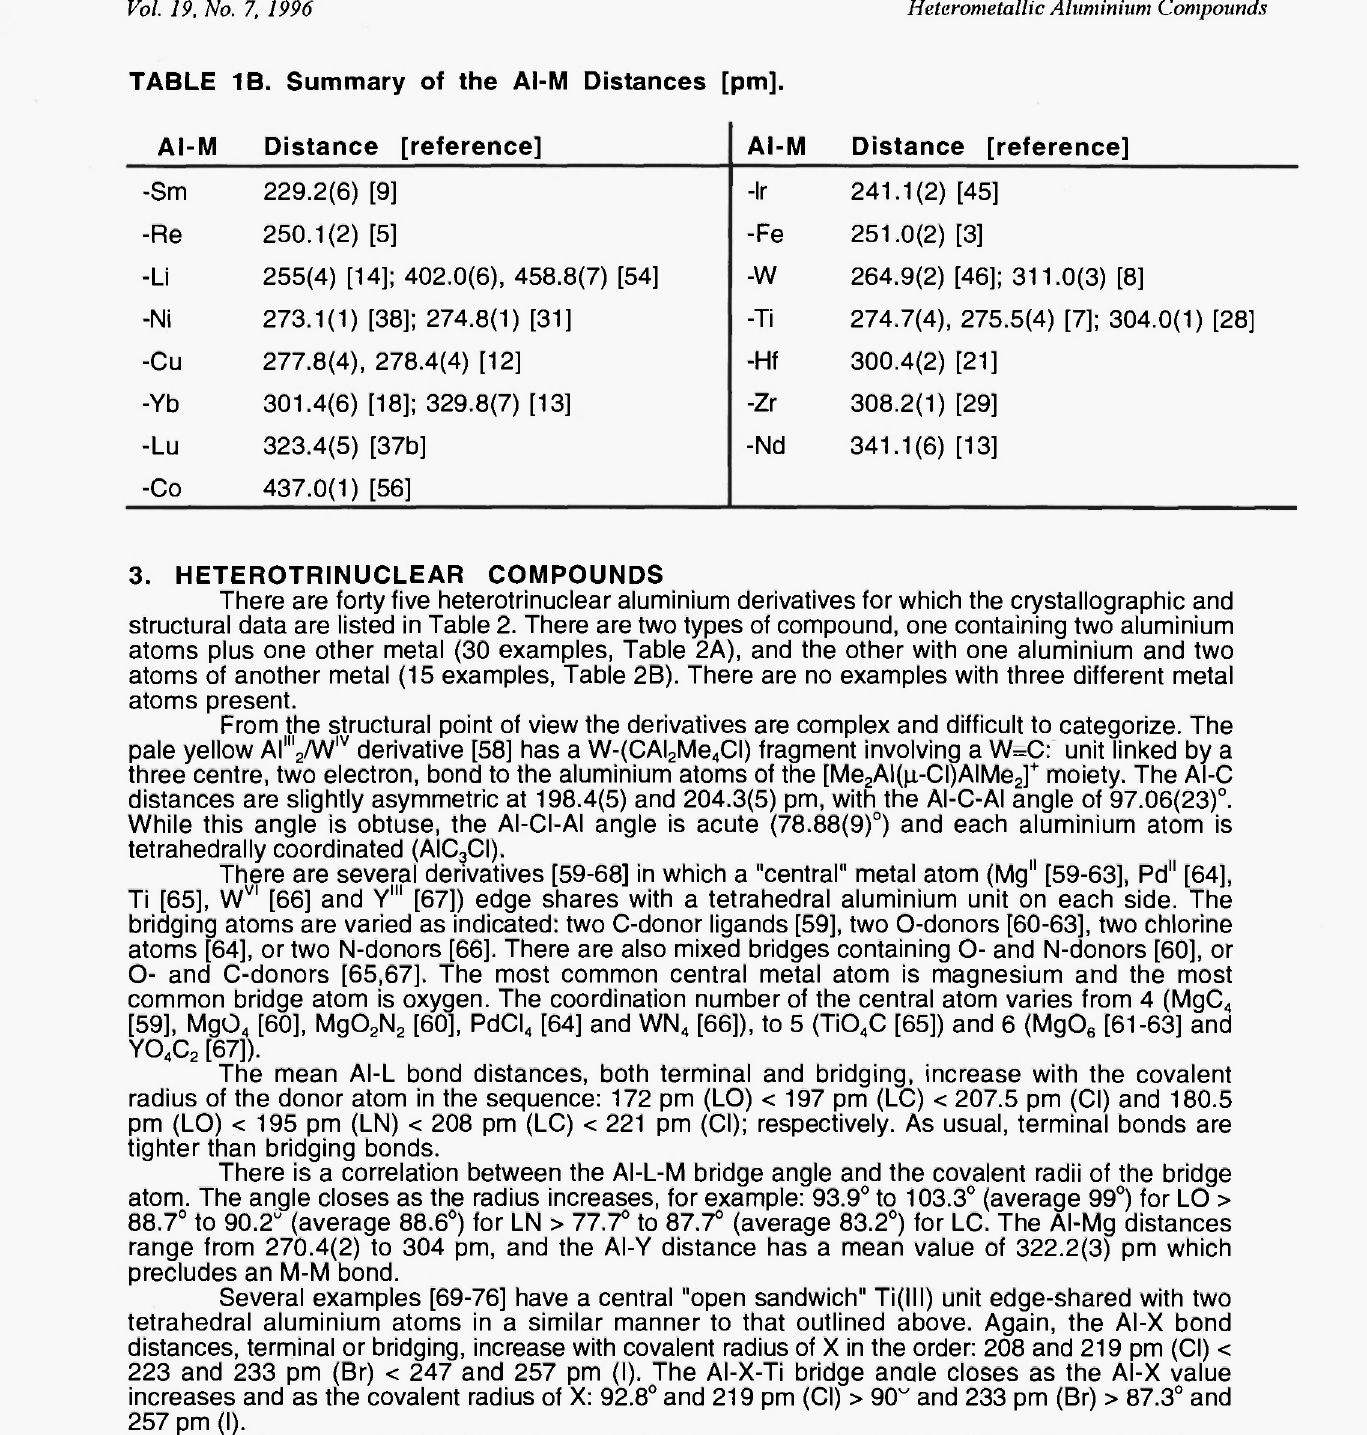
TABLE 1B. Summary of the Al-M Distances